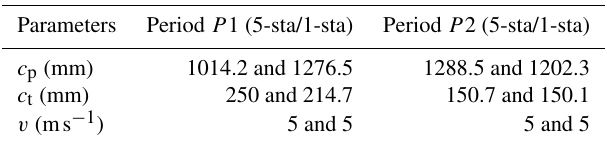
Table 5. Optimal uniform set of parameters for experiments uniform-5-sta and